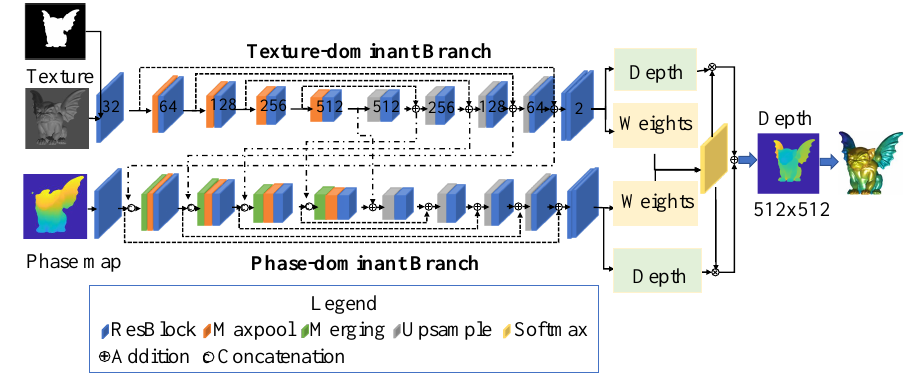
Figure 2. Schematic of the proposed